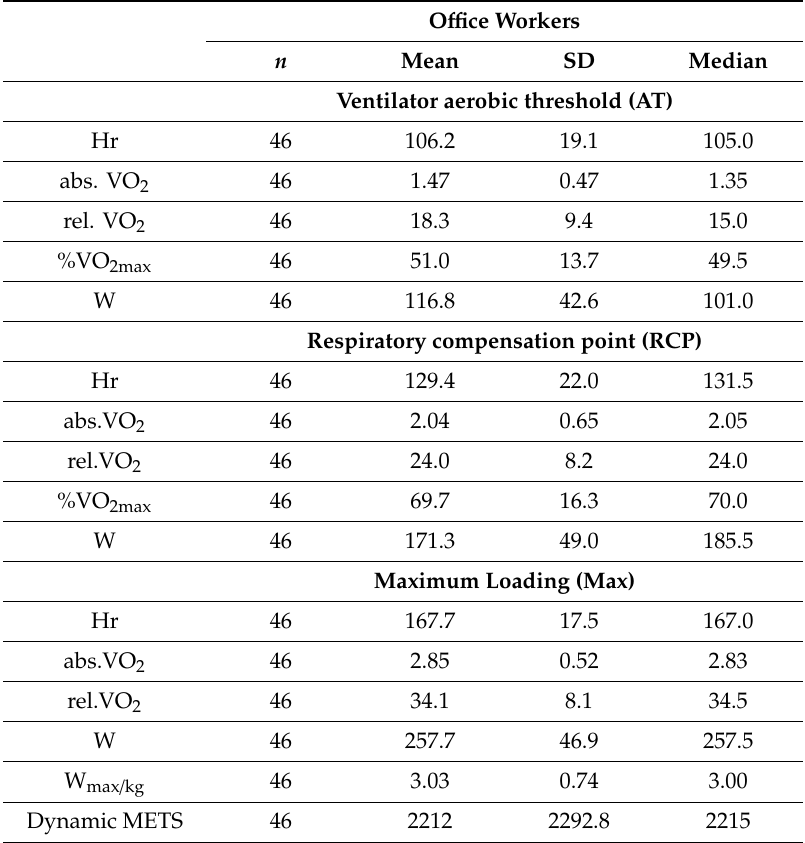
Table 6. Spiroergometry and physical activity results of o ffi ce